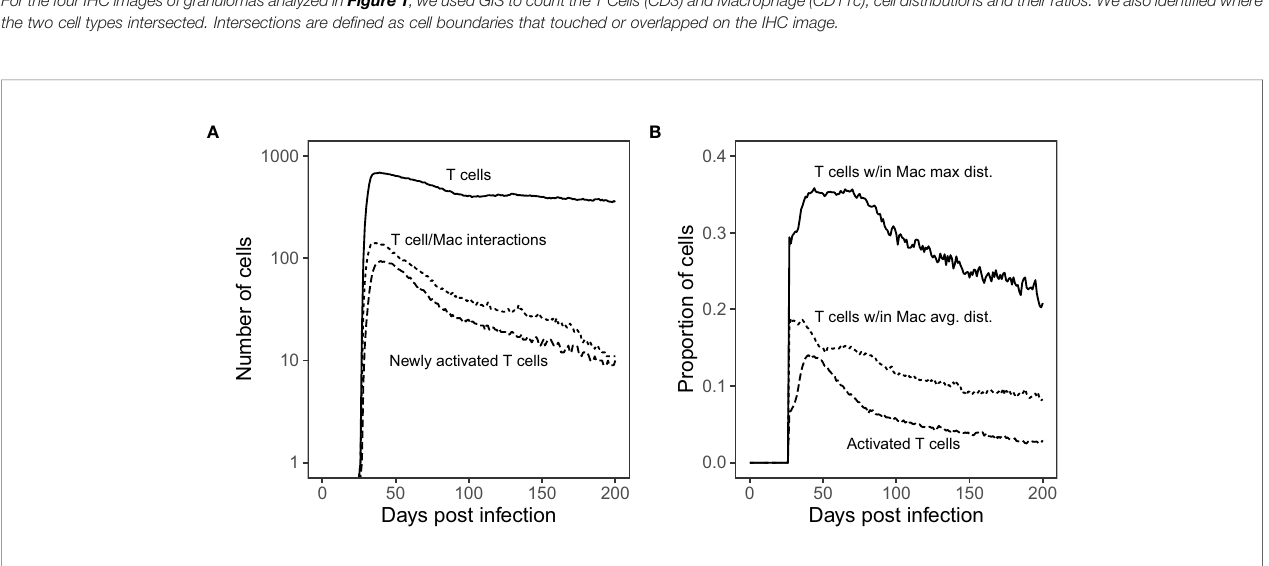
FIGURE 5 | Simulated T cell/Macrophage Interactions in time Shows Spatial Analysis of Simulated Granulomas. Panel (A) : Median count T cells over the course of Mtb infection compared with the median count of distinct T cells that interact with macrophages and new T cell activations per time step. Panel (B) : Proportion of T cells found within the maximum boundary and average distance of antigen-presenting macrophages (measured from the granuloma center of mass) as compared with the proportion of total activated T cells (all activated T cells are Mtb-speci fi c). These distances are shown spatially in Figure 6 .